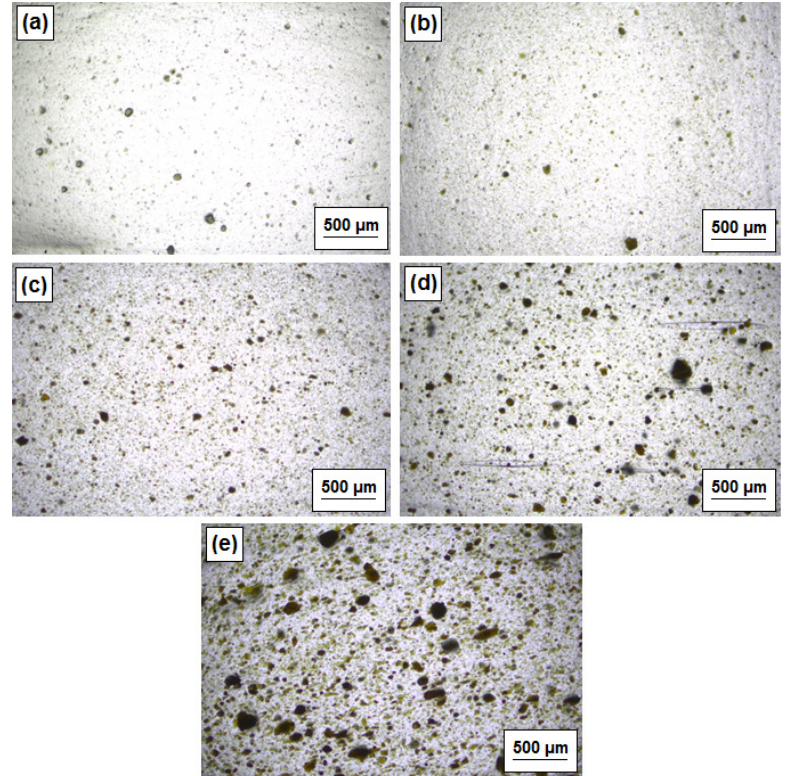
Figure 2. The distribution of MgO, lignin, and MgO-lignin hybrid particles in the LDPE matrix: LDPE / MgO ( a ), LDPE / MgO-L (5:1 wt. / wt.) ( b ), LDPE / MgO-L (1:1 wt. / wt.) ( c ), LDPE / MgO-L (1:5 wt. / wt.) ( d ) and LDPE / lignin ( e ).